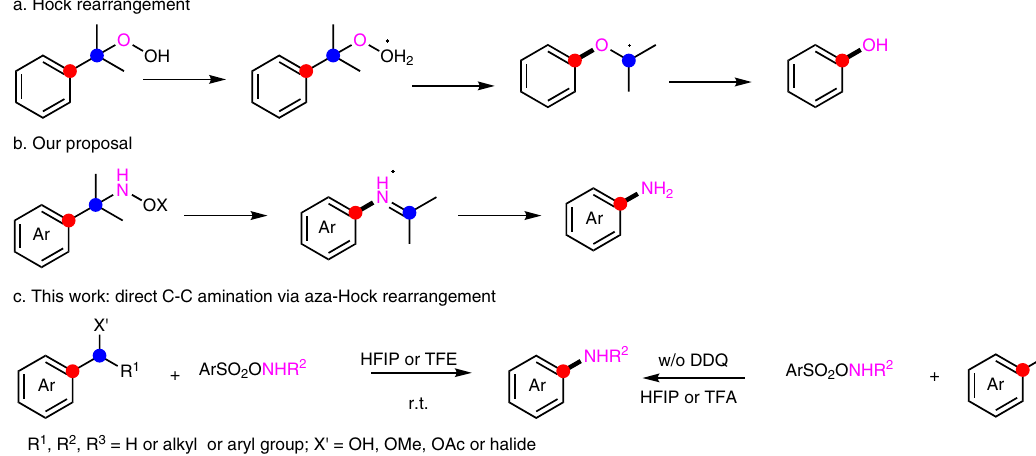
Fig. 1 Hock rearrangement and reaction design for C – C amination. Color labels are used to visualize the disconnection. a Hock rearrangement for phenol synthesis. b Our proposal for aniline synthesis. c This work with direct C – C amination via aza-Hock rearrangement. DDQ 2,3-dichloro-5,6-dicyano-1,4- benzoquinone, HFIP hexa fl uoroisopropanol, TFE tri fl uoroethanol, TFA tri fl uoroacetic